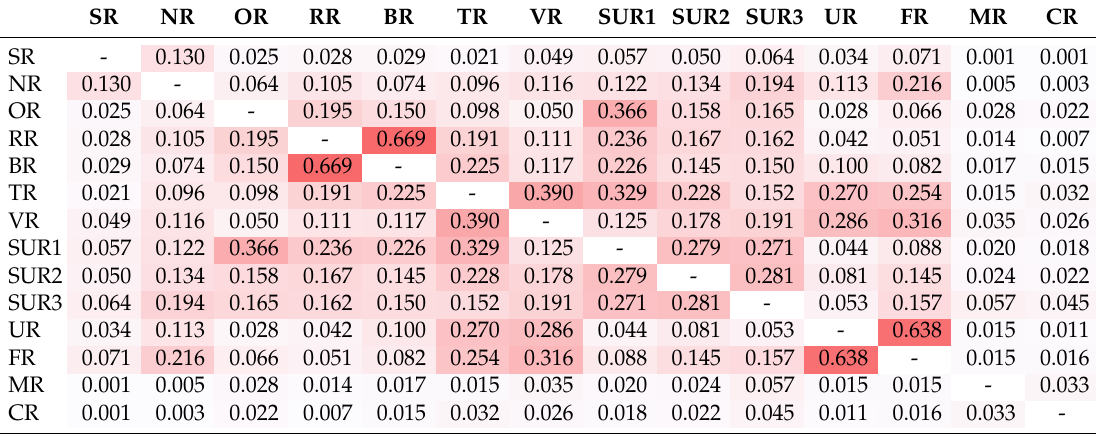
Table 3. The mutual information matrix representing the mutual information (MI) values between each pair of attributes of the evaluated